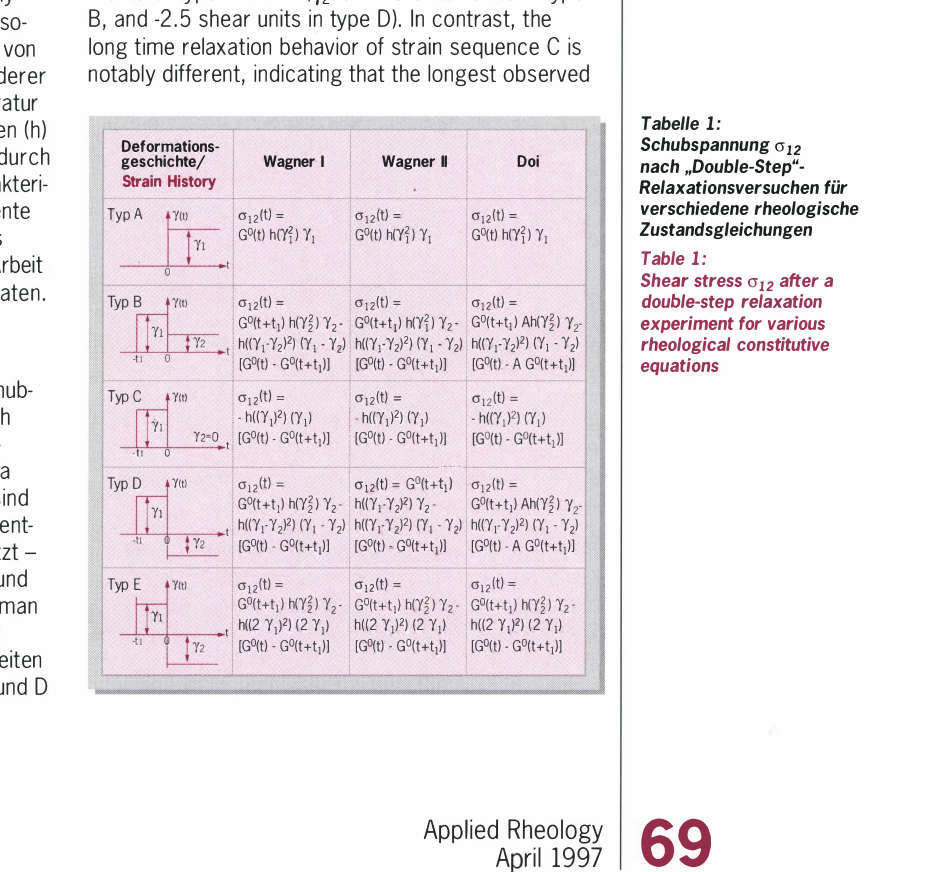
Tabe/le 1: Schubspannung cr12 nach .Double-Step"­ Relaxationsversuchen fur